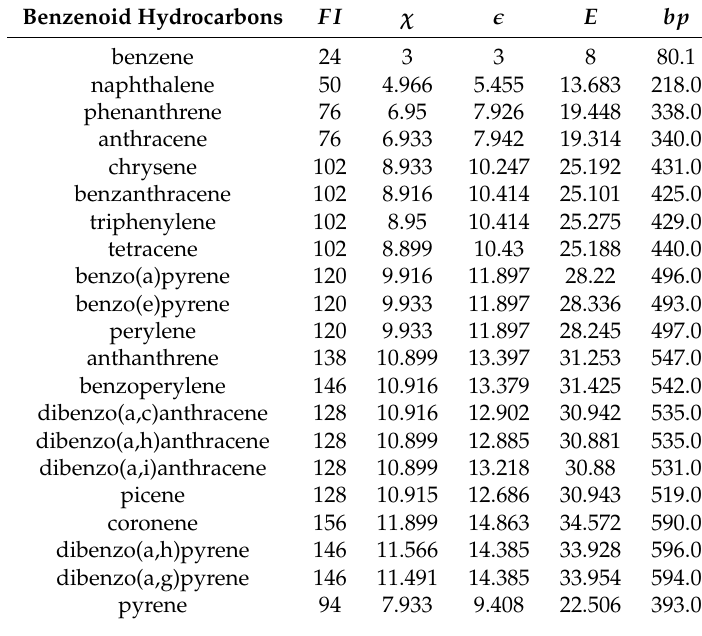
Table 1. The face index ( FI ), Randi´c index ( χ ), edge-connectivity index ( ε ), π -electron energies ( E ) in β and boiling points ( bp ) in o C of studied benzenoid